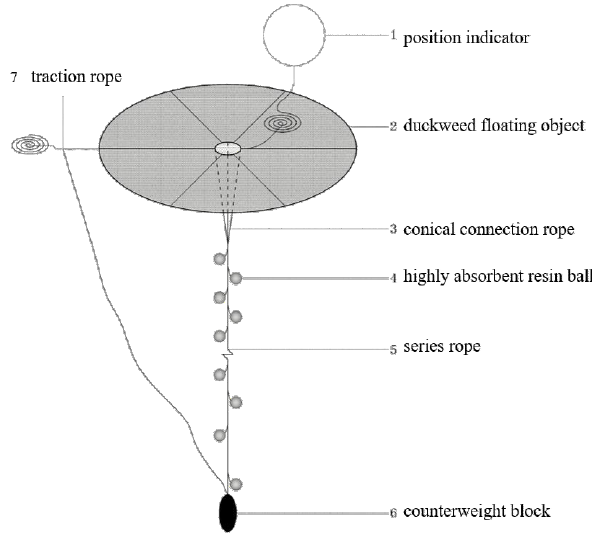
Figure 3. A duckweed dam leak-plugging device.